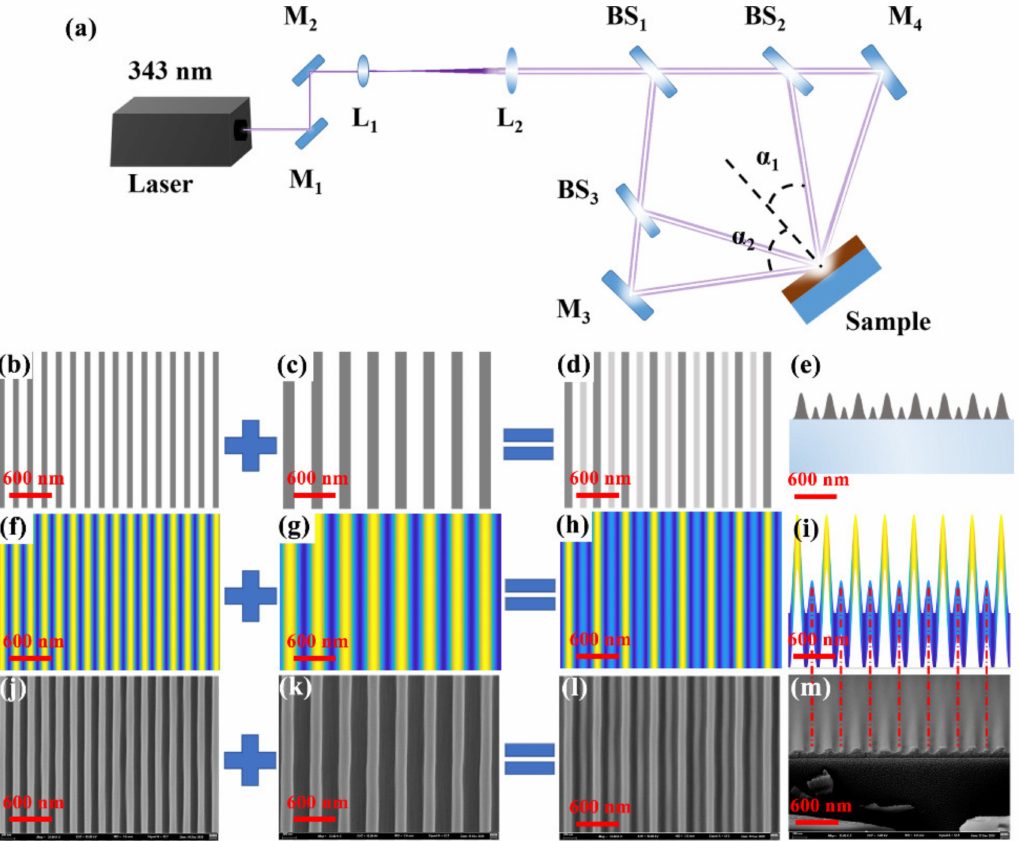
Figure 1. ( a ) Optical layout used for interference lithography. M 1 , M 2 , M 3 , and M 4 represent reflectors. L 1 and L 2 represent lenses. BS 1 , BS 2 , and BS 3 represent beam splitters. Angles 2 α 1 and 2 α 2 correspond to the included angles between the two interference beams. Schematics of ( b ) the first-order grating, ( c ) the second-order grating, and ( d , e ) the holographic dual-grating. ( f – i ) Simulated interference patterns corresponding to the structures shown in ( b – e ), respectively. ( j – m ) SEM images corresponding to the structures shown in ( b – e ),